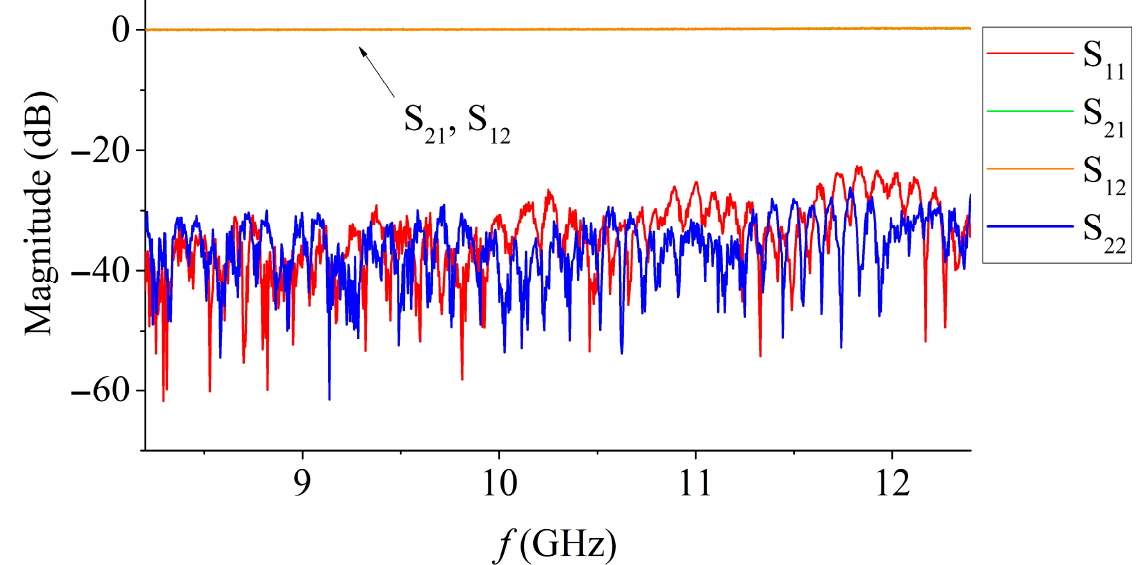
Figure 2. S-parameters of an empty waveguide measuring cell.